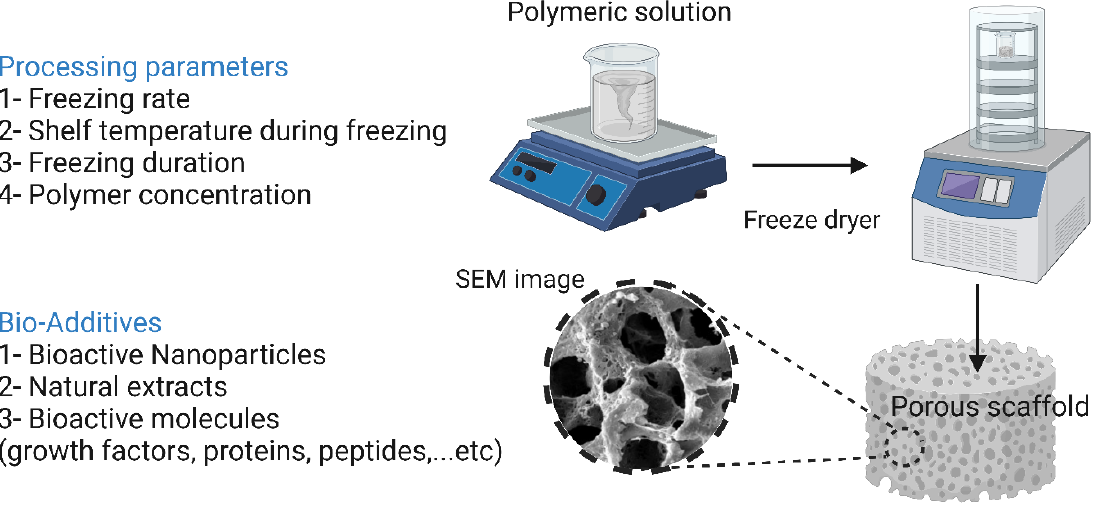
Figure 10. Freeze-drying technique and its processing parameters and additives. The image was created using Biorender.